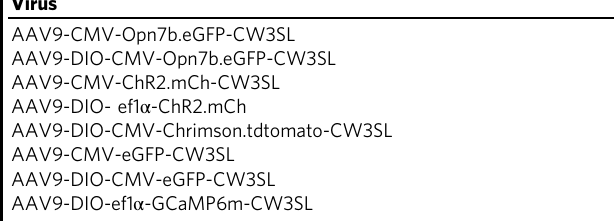
Table 1 List of adeno-associated virus for in vivo